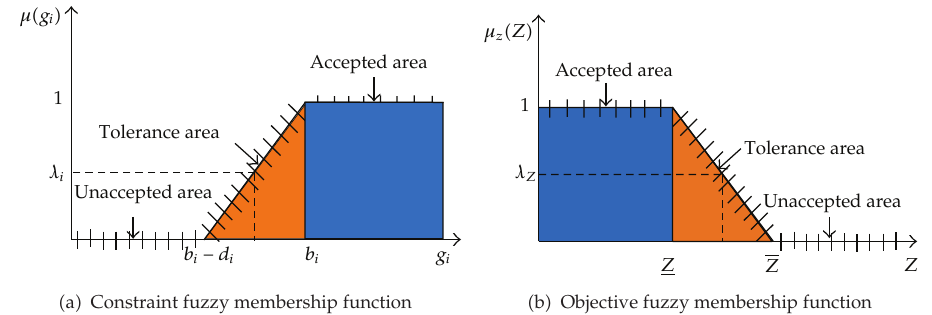
Figure 1: Fuzzy membership